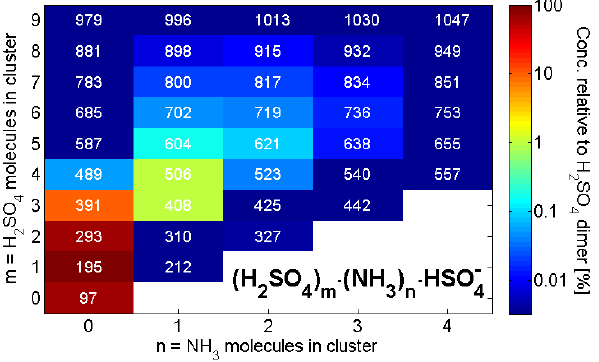
Fig. 9. Relative abundances of observed (H 2 SO 4 ) m (NH 3 ) n HSO − 4 clusters. The white numbers correspond to the integer masses at which the clusters were detected. Concentrations are scaled to the dimer ion at integer m/Q 195.